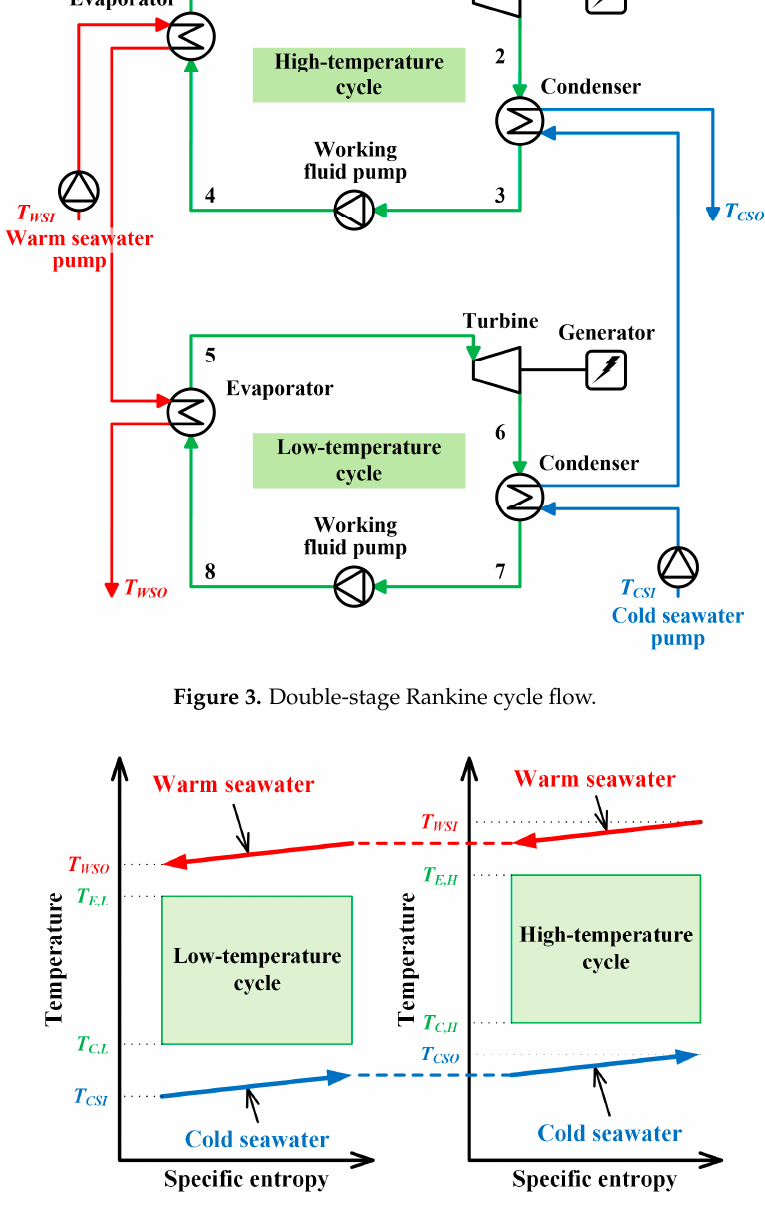
Figure 4. Conceptual T-s diagram of double-stage Rankine cycle.